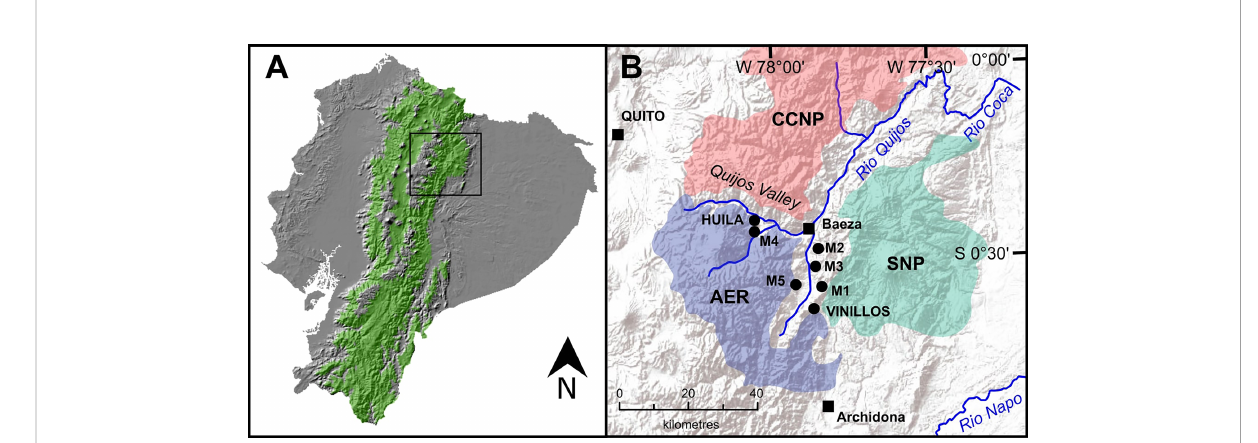
FIGURE 1 (A) Republic of Ecuador with elevations corresponding to Andean montane forest (1300-3,600 m asl) highlighted in green. (B) The Quijos Valley and surrounding protected areas, Antisana Ecological Reserve (AER), Cayambe Coca National Park (CCNP), and Sumaco Napo-Galeras National Park (SNP). Black squares indicate population centres. Black dots indicate location of study sites (Loughlin et al., 2018a; Loughlin et al.,